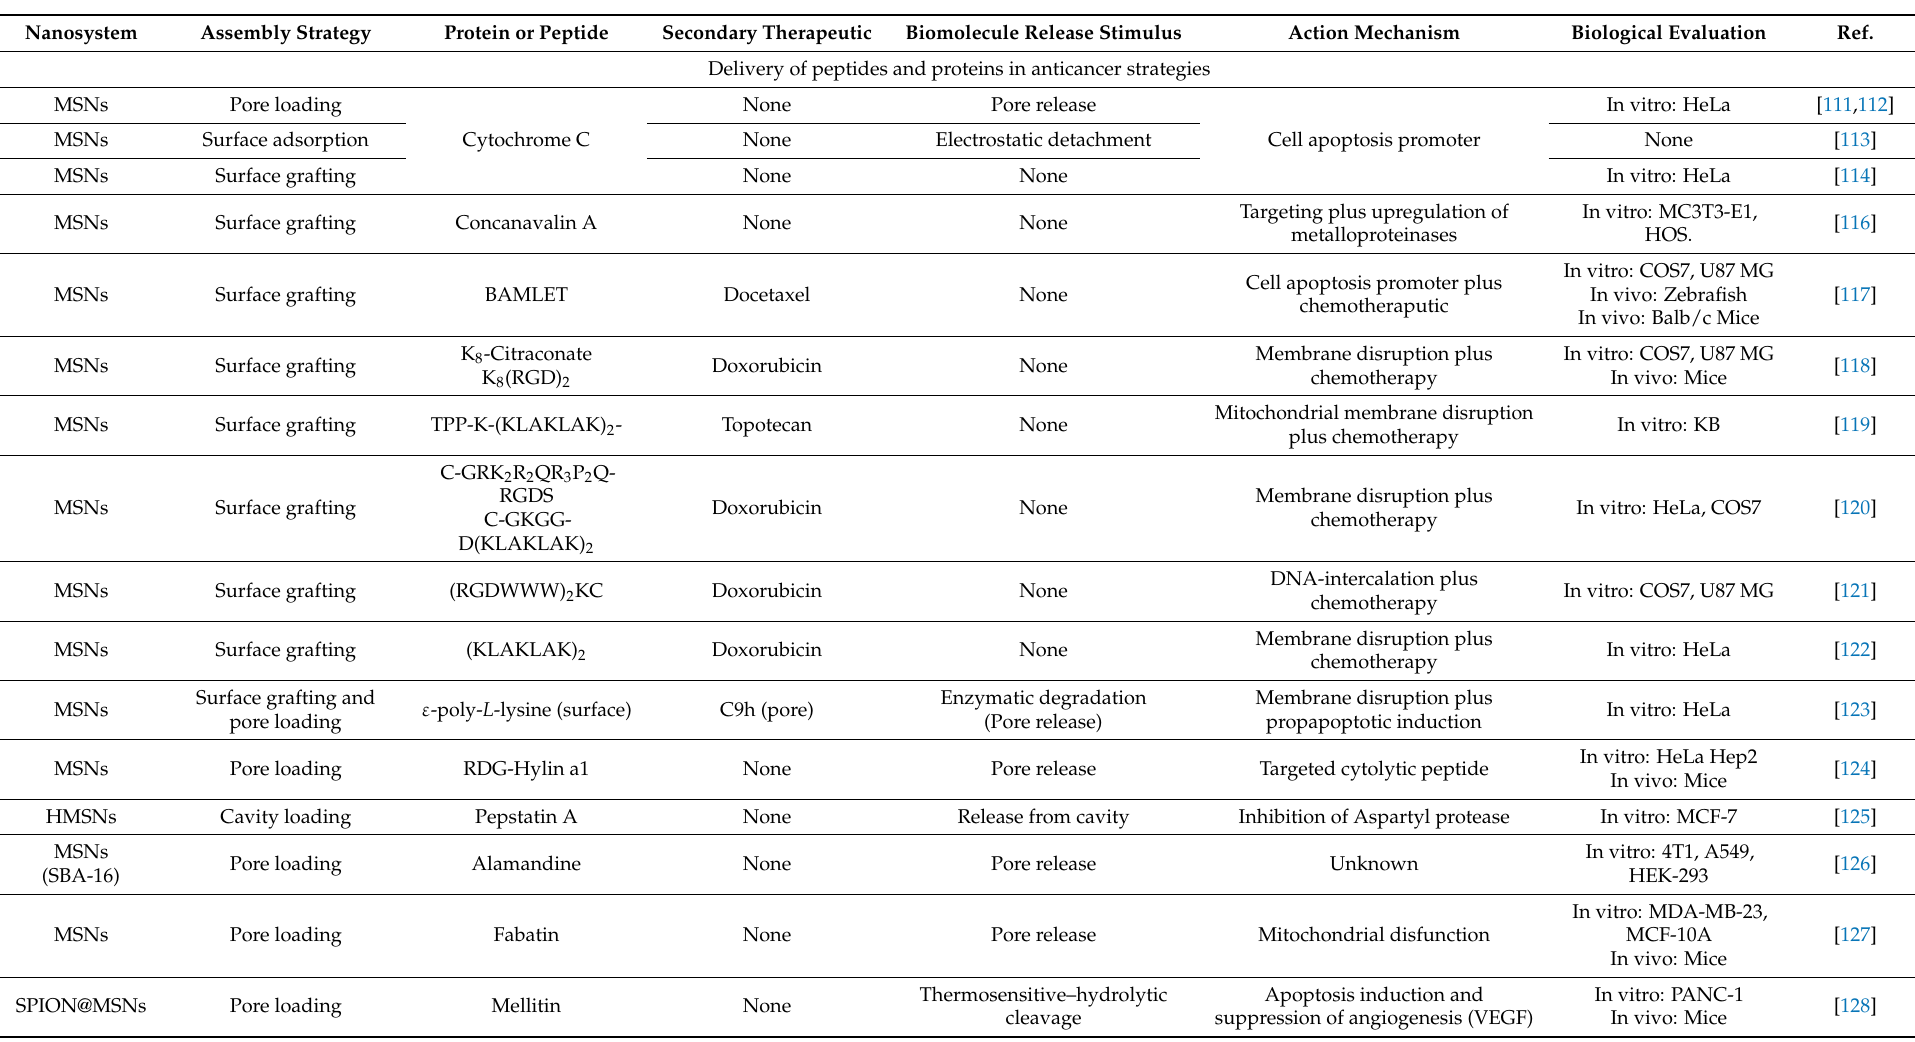
Table 2. Examples of therapeutic proteins and peptides delivered by silica-based nanocarriers. For an illustrative review on the coupling protocols employed for linking peptides onto nanocarriers, please check reference